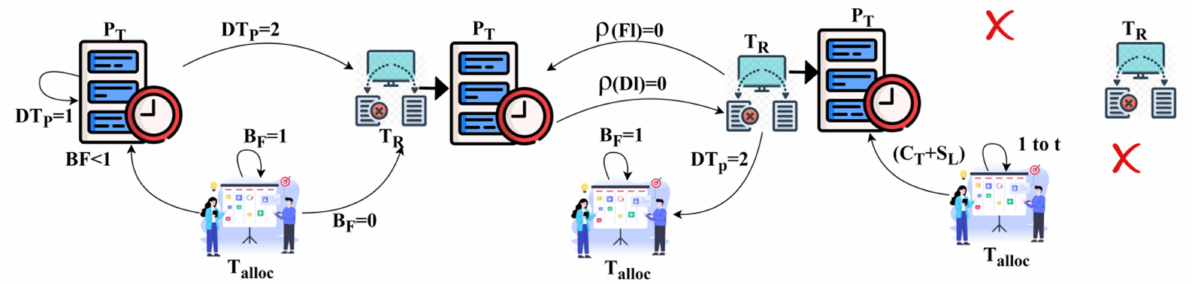
Figure 3. State Learning for Pending and Reassignment task